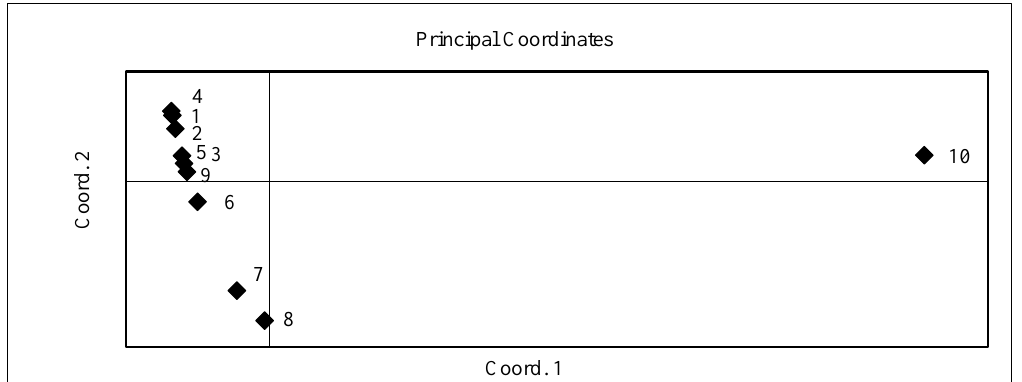
Figure 2. Scatter plot of different basil cultivars according to the results of principled coordinate analysis (PCoA) of productivity and net mass in 2017 – 2018. Basil cultivars: 1 — Sweet Genovese; 2 — Toscano; 3 — Classic Italiano; 4 — Siam Queen; 5 — Fino Verde; 6 — Cinnamon; 7 — Compact; 8 — Purple Opal; 9 — Rosie; 10 — Holly.